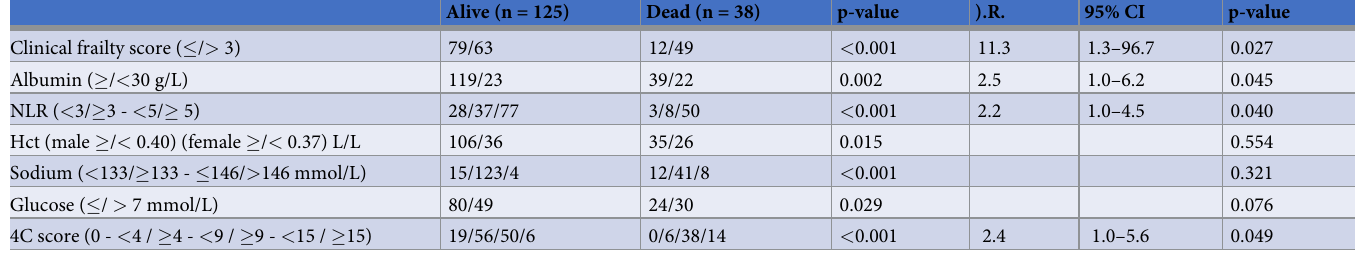
Table 6. Binary logistic regression analysis of demographical, clinicopathological characteristics and 30-day mortality in the second cohort of patients admitted with confirmed COVID-19 (n =